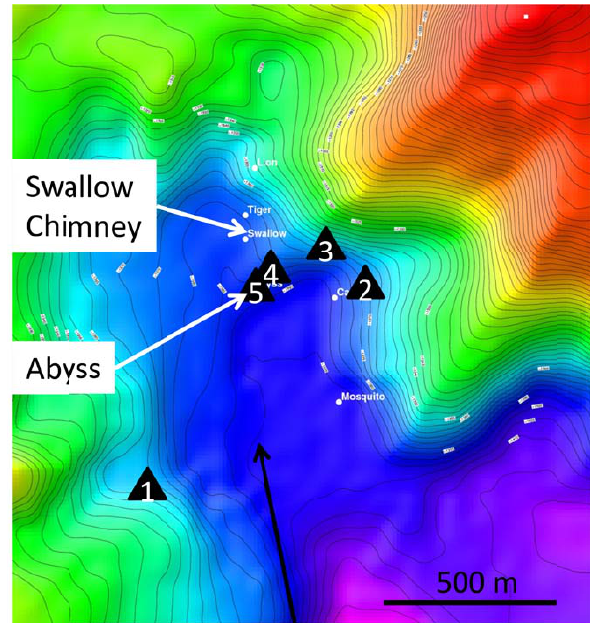
Fig. 1. Bathymetric map of the working area. The microprofiler lo- cations are indicated, at 550m (1, Reference, MP1 2010), 125m (2, MP2 2010), 100m (3, MP3 2008), 10m (4, MP1 2008) and 0.5m (5, MP2 2008) distance from Abyss Vent. The black arrow indicates the main bottom water current